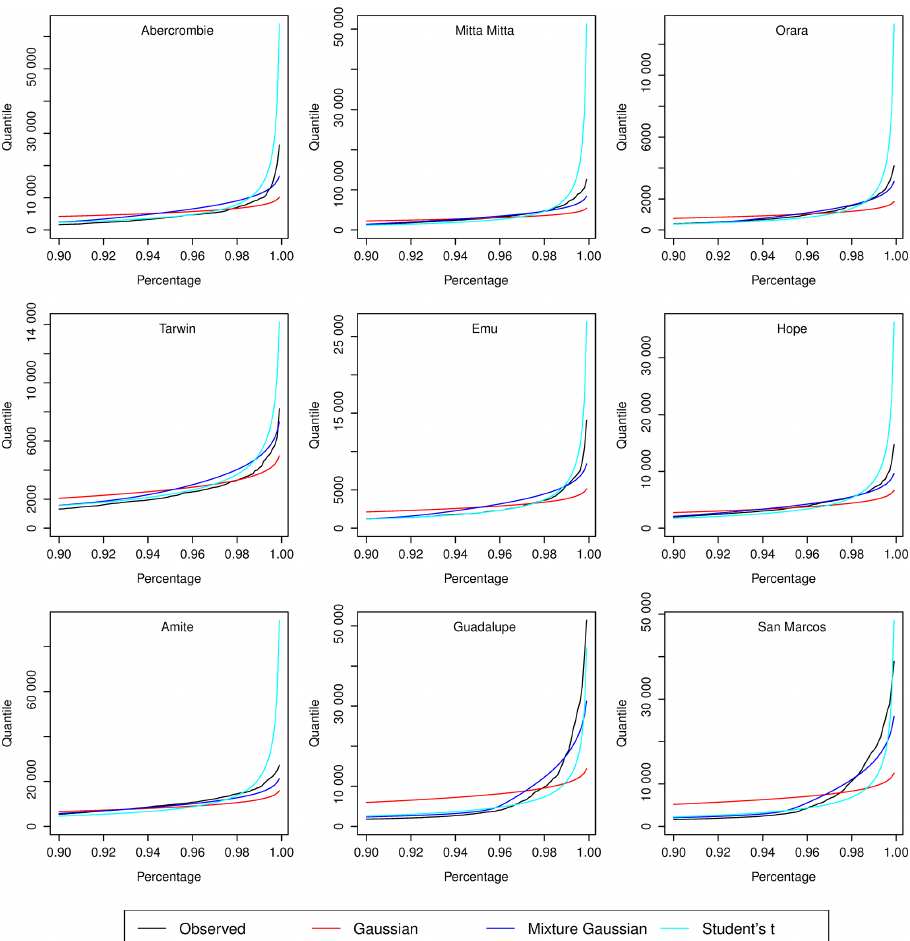
Figure 7. Comparison of streamflow observations with streamflow forecast mean for each catchment when the residual distribution is fitted by Student’s t